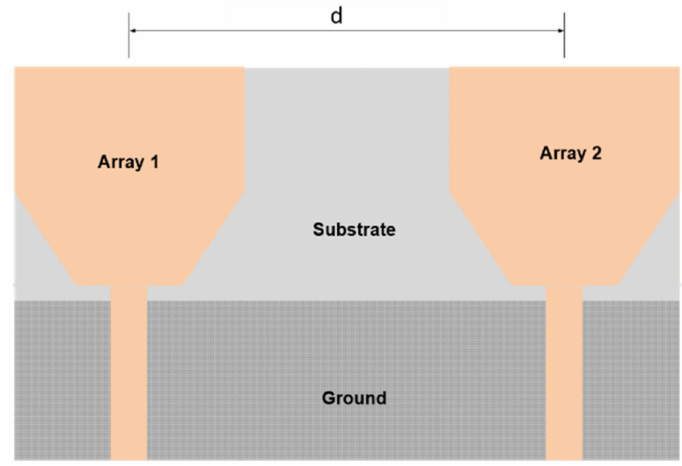
Figure 4. UWB patch MIMO antenna without MEBG decoupling structure.